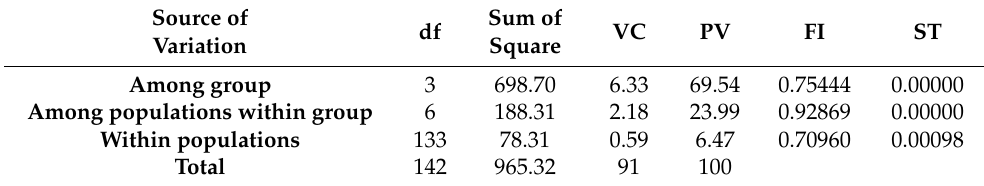
Sum of df VC Square